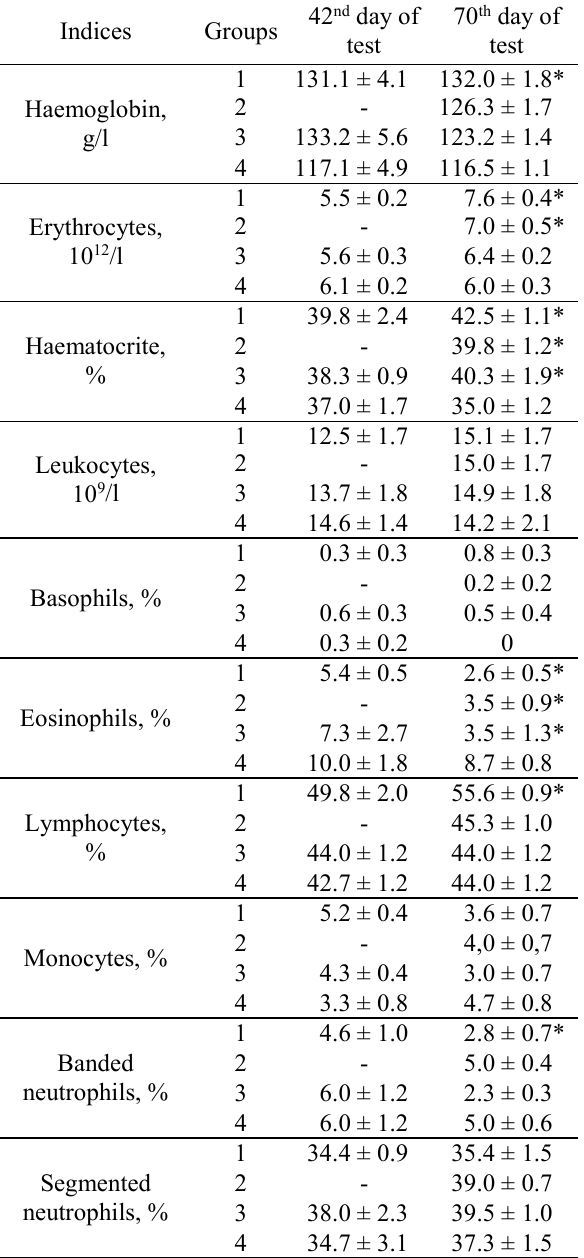
Morphological indices of blood of piglets at application of probiotic feed additive (М± m, n=10)